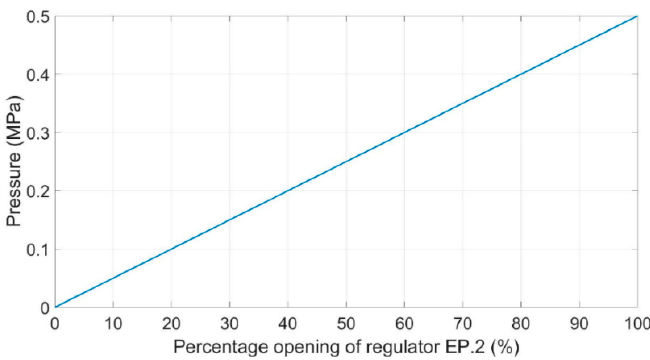
Figure 19. Relation between opening of regulator EP.2 and output pressure.